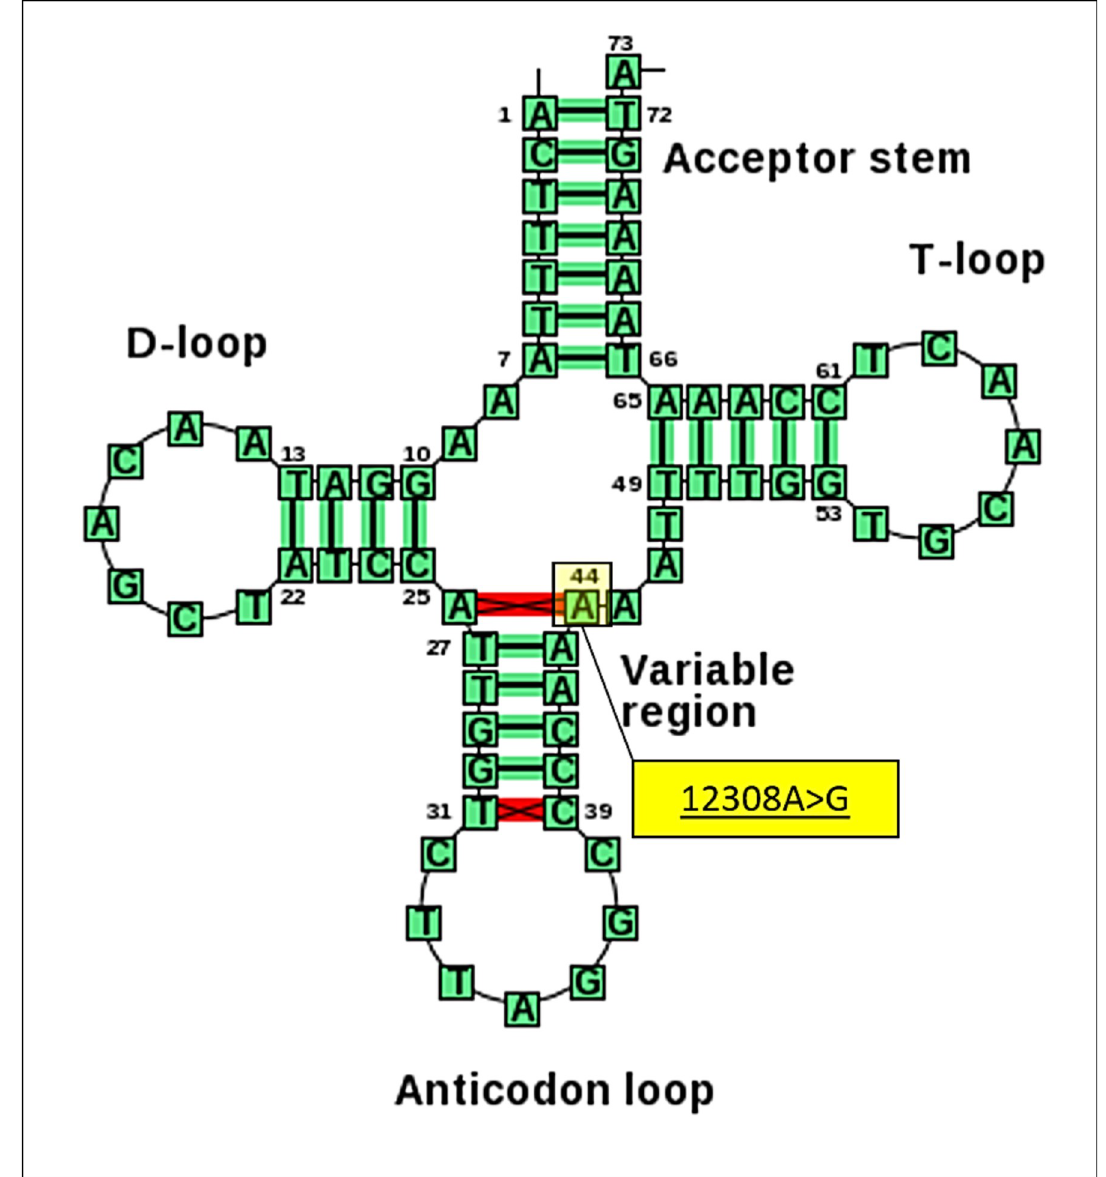
Fig 2. Secondary structure prediction of tRNA Leu(CUN) by the web servers for tRNA secondary structures (Mamit-tRNA http:// mamit-trna.u-strasbg.fr/). The m.12308A > G variant created a novel Watson-Crick base-pairing (A25-T43) in the variable region of mitochondrial tRNA Leu(CUN)